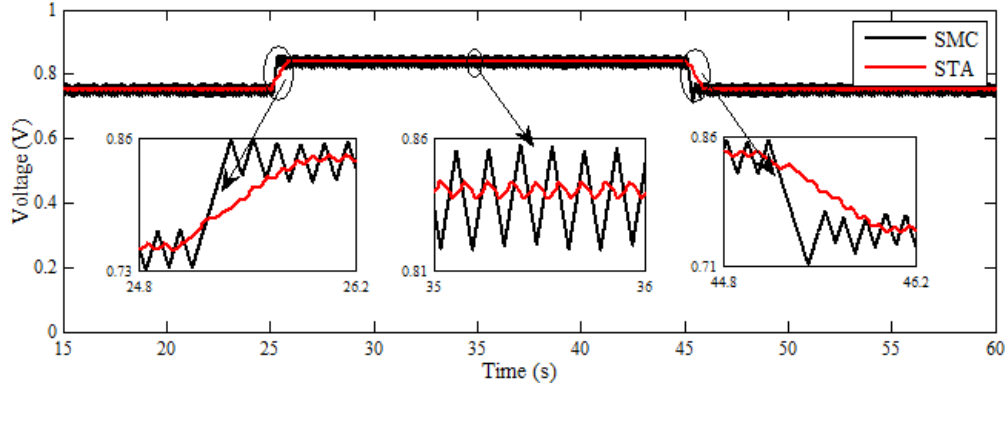
Figure 11. Duty cycle